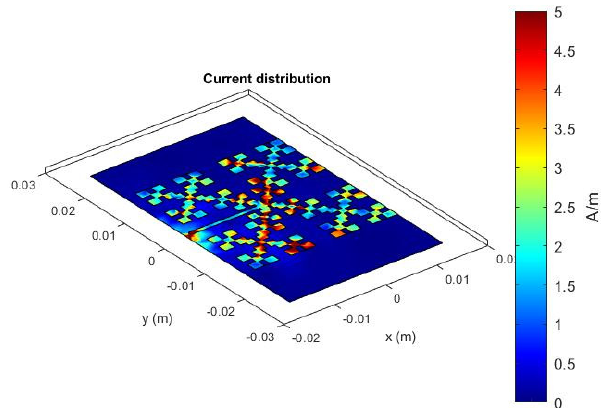
Figure 7. Current distribution of fractal island antenna (lateral alimentation).